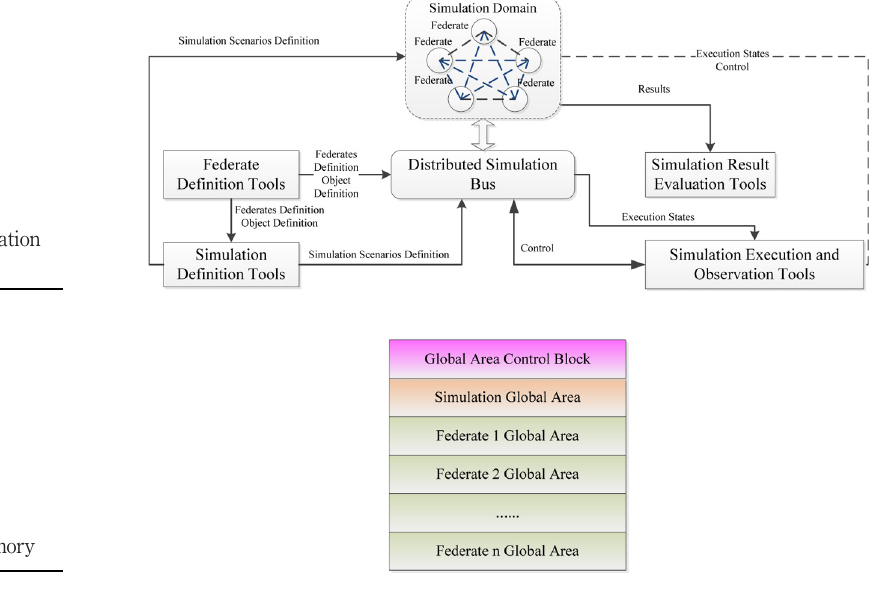
Figure 4. Re fl ective